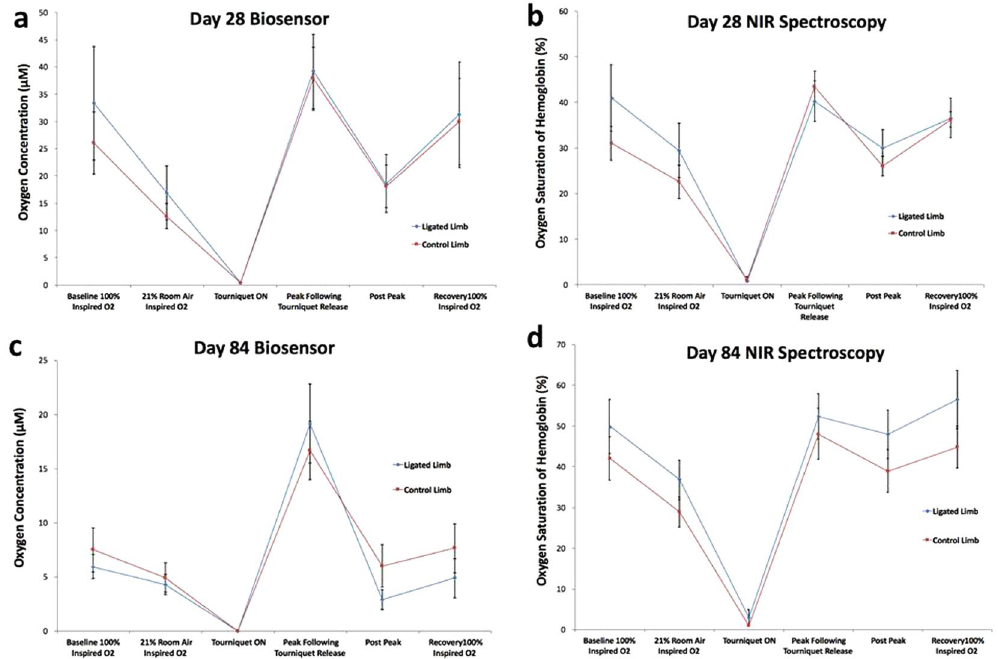
Figure 5. Compiled mean oxygen measurements by day and technique for both limbs: ( a ) Day 28 Biosensor, ( b ) Day 28 NIR Spectroscopy, ( c ) Day 84 Biosensor, ( d ) Day 84 NIR Spectroscopy. Note that techniques demonstrate no significant differences between post peak vs pre-tourniquet and recovery vs baseline on 100% inspired O 2 .